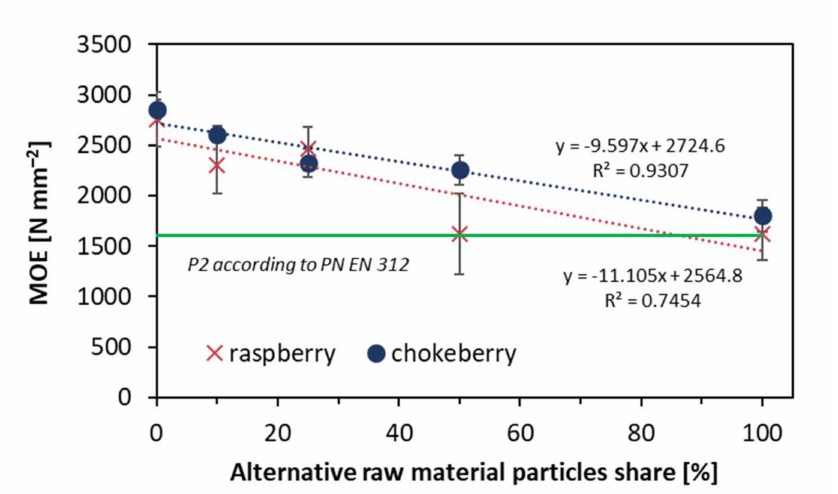
Figure 6. Modulus of elasticity of the tested